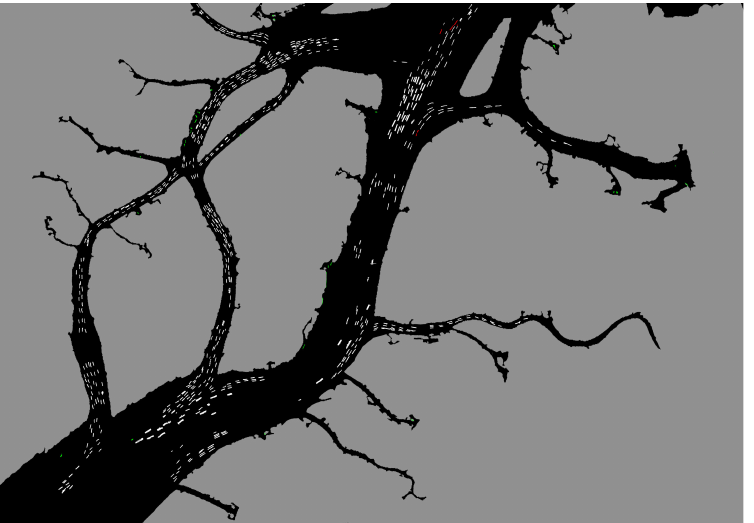
Figure 4. The IEGD algorithm (10) is applied to extract rafts from the whole study area, where white denotes rafts, black denotes sea water, gray denotes land, red denotes the missing extraction, and green denotes greater